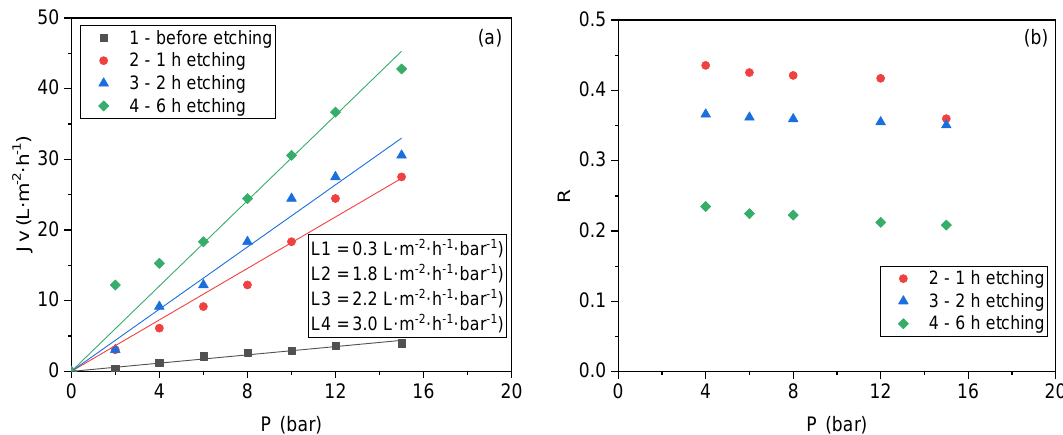
Figure 4. Plots of the flux ( a ) and 0.2% CaCl 2 salt rejection ( b ) against pressure for membranes obtained at different acid etching times.